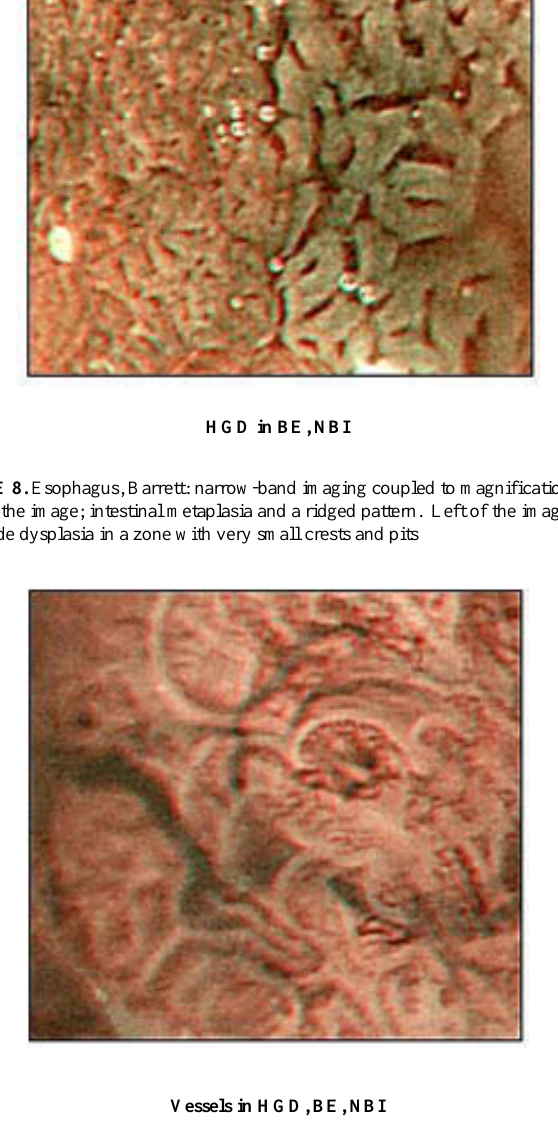
Vessels in HGD, BE, NBI FIGURE 9. Esophagus, Barrett: narrow-band imaging coupled to magnification. High-grade dysplasia in a zone with irregular enlarged and branched epithelial crests. Vessels with a large and irregular caliber are colored in dark